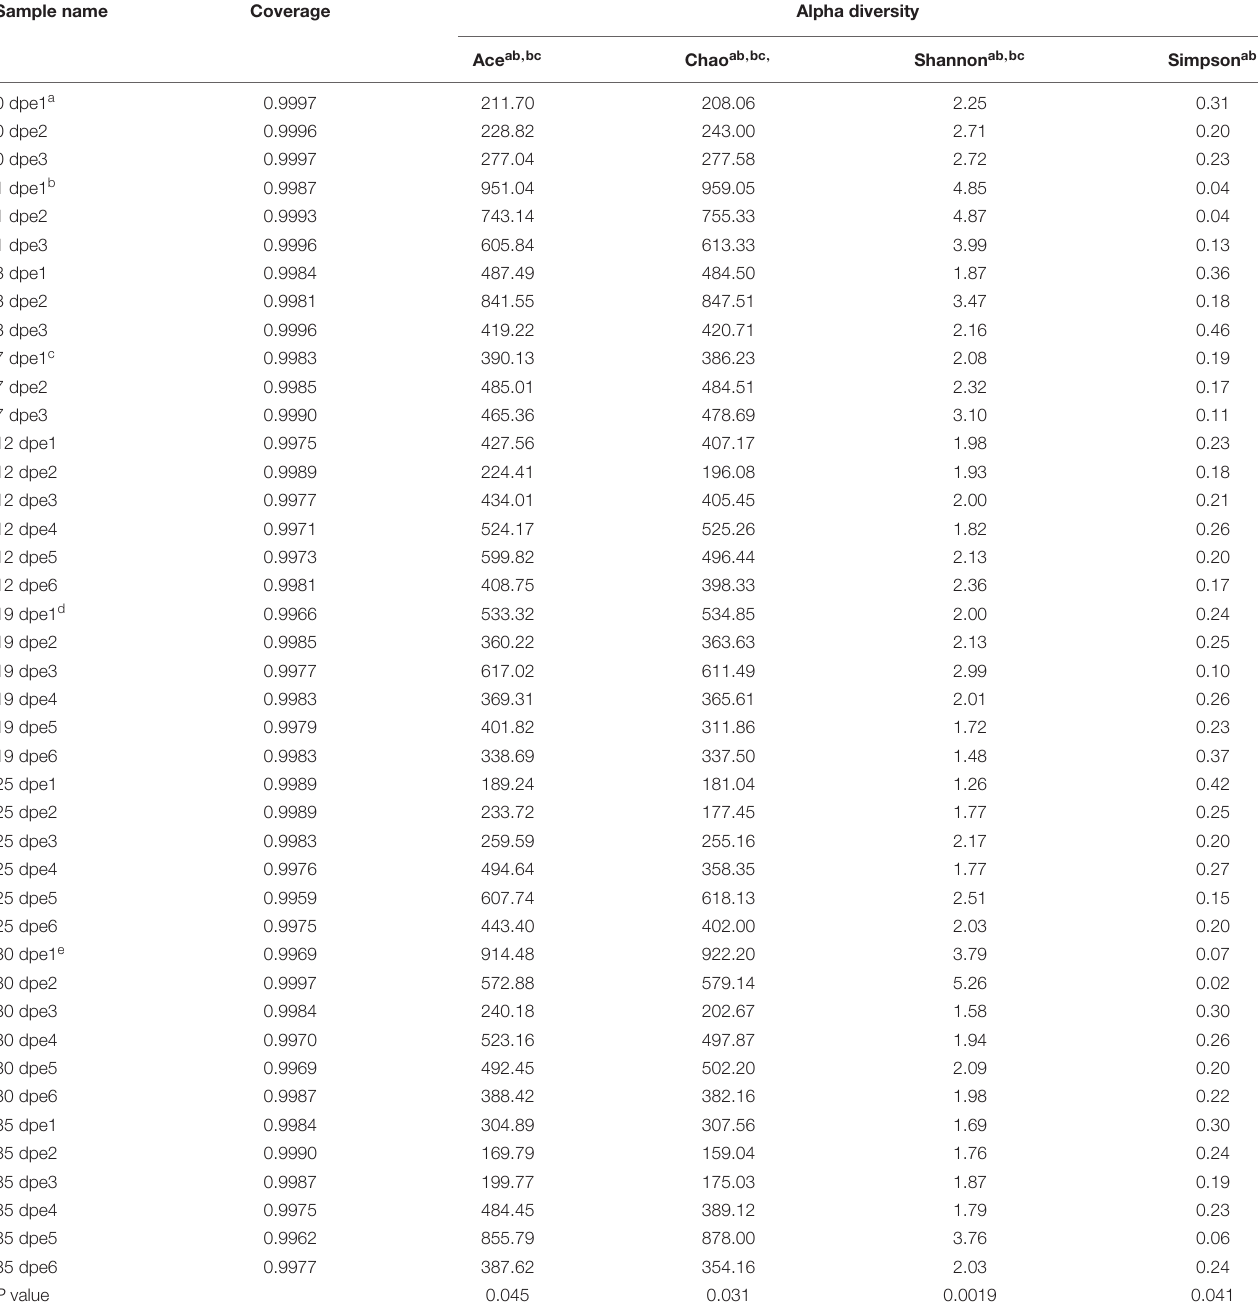
TABLE 1 | Richness and diversity indices relative to each gut